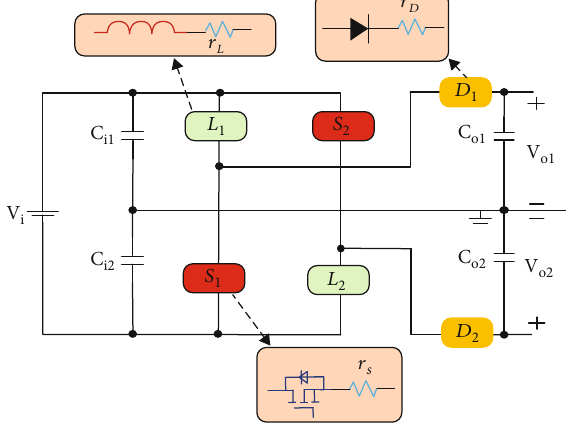
Figure 8: The equivalent circuit of the proposed converter with nonidealities.